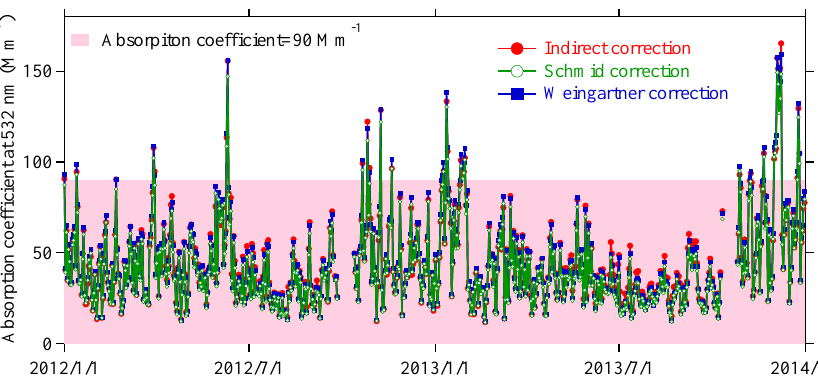
Figure 11. Time series of daily mean aerosol absorption coefficient at 532nm corrected by IDC (red), WC2003 (blue) and SC2006 (green) in the period from 2012 to